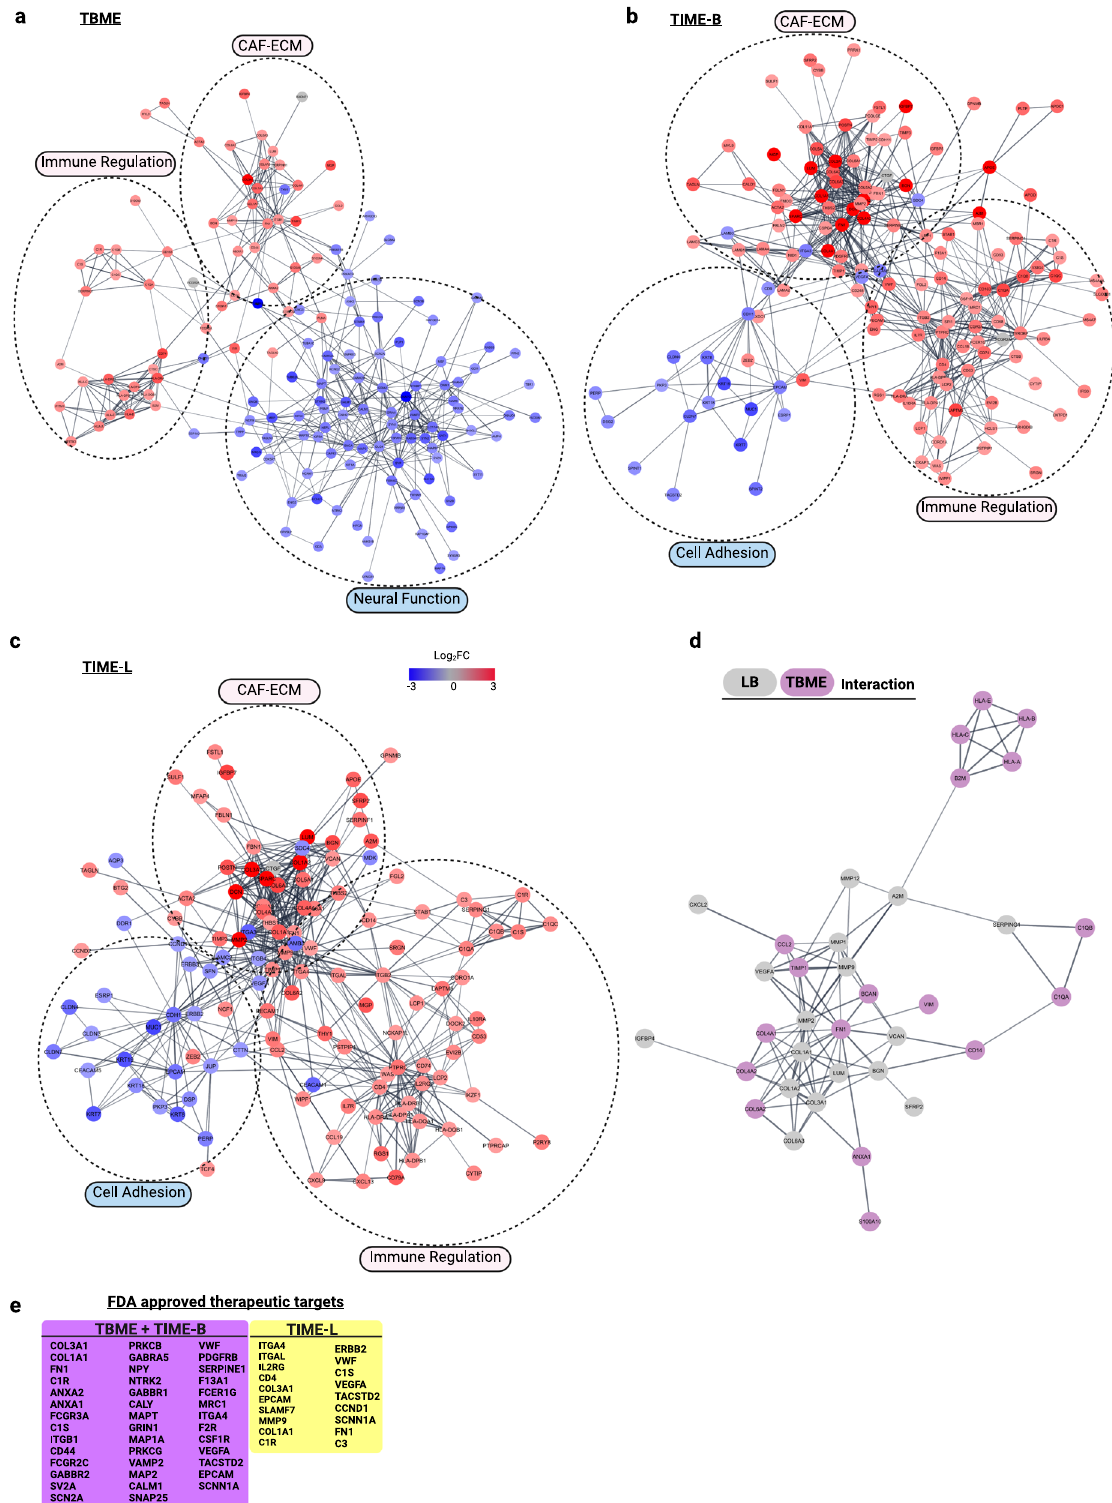
Fig.7|GeneassociationnetworkanalysisrevealsTMEmodulesfortherapeutic targeting.a – c SnapshotsofthegeneassociationnetworksintheTBME( a ),TIME-B ( b ), and TIME-L ( c ) based on the corresponding DEGs. Functional modules are identi fi ed by broken circles. Network DEGs colored from blue to red according to